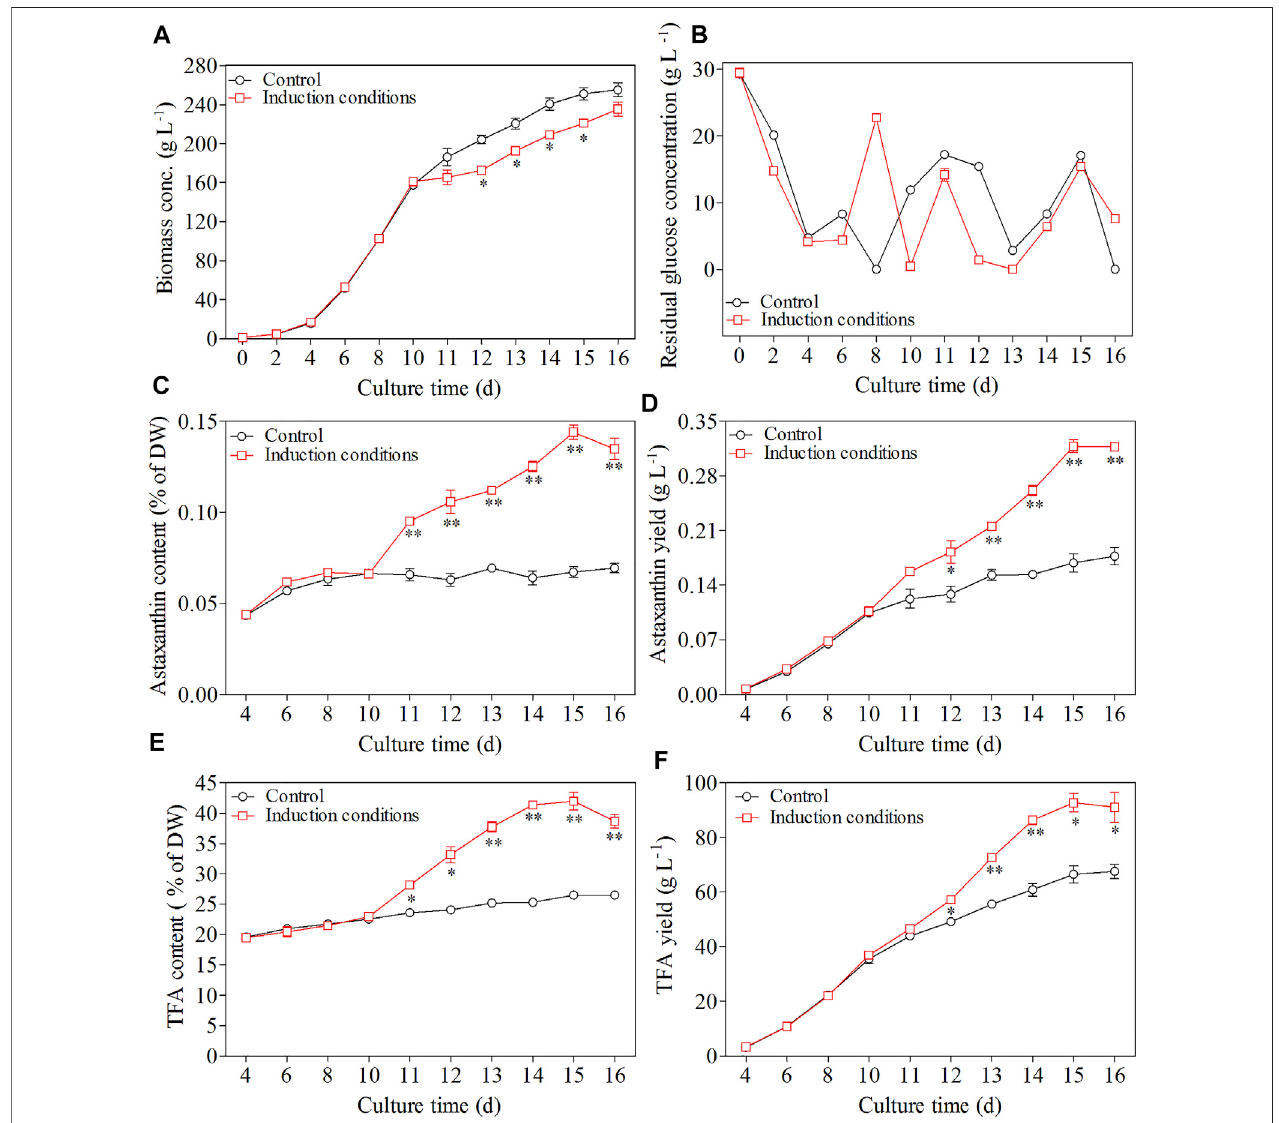
FIGURE 7 | Effect of induction conditions on the growth of C. zo fi ngiensis and astaxanthin production during the heterotrophic cultivation in 7.5 L fermentors. (A) Timecourseofdrycellweight. (B) Residualglucoseconcentration. (C) Astaxanthincontent. (D) Astaxanthinyield. (E) TFAcontent (F) TFAyield.Inductionconditions,the C/Nratioofthefeedingmedium changeto180:1withtheadditionof10 mg L − 1GA3and200 mMNaClattheendof10 days.Dataaremeanvalues±SDfromtriplicate measurements (n = 3). * and ** were statistically signi fi cant at p < 0.05 and p < 0.01, respectively.